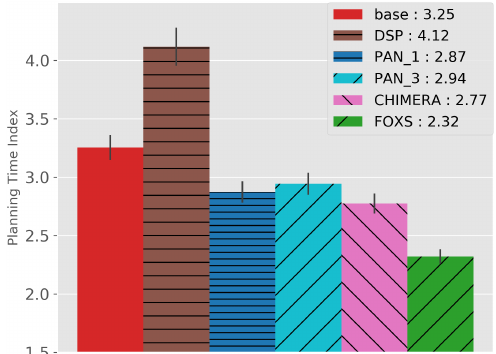
Figure 10. Planning Time Index (PTI)—Ottawa